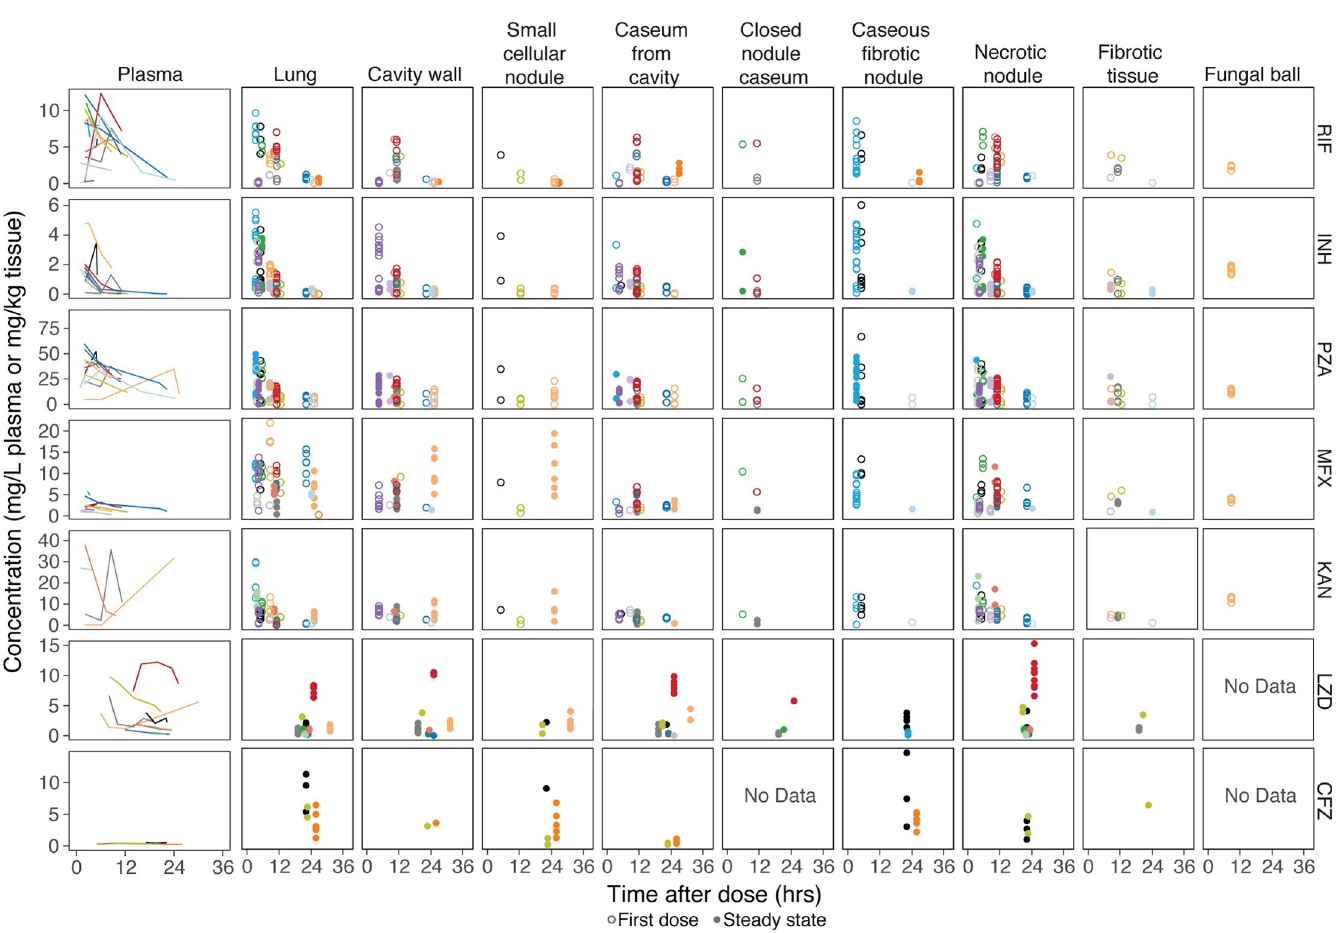
Fig 1. Raw clinical data for each drug in each lesion type. Concentration–time profiles are shown for 9 lesions and 7 drugs by respective panel. Plasma concentrations over time for each individual were measured at multiple time points after the time of drug administration and before lung resection and are shown as individual lines of different colors. Lesion concentrations were measured at a single time point (time of resection) per subject and are represented by circles of different colors that correspond to their individual subject plasma line. Closed circles show patients assumed to be at steady state, and open circles show patients receiving the drug for the first time. Some subjects received LZD and CFZ in their background regimen, and their last CFZ and LZD doses were administered on the day preceding the resection, leading to tissue samples after 24 h. None of the patients receiving LZD and CFZ had fungal ball lesions, and those patients on CFZ also didn’t have closed nodule caseum lesions. CFZ, clofazimine; INH, isoniazid; KAN, kanamycin; LZD, linezolid; MFX, moxifloxacin; NA, not available; PZA, pyrazinamide; RIF, rifampicin.